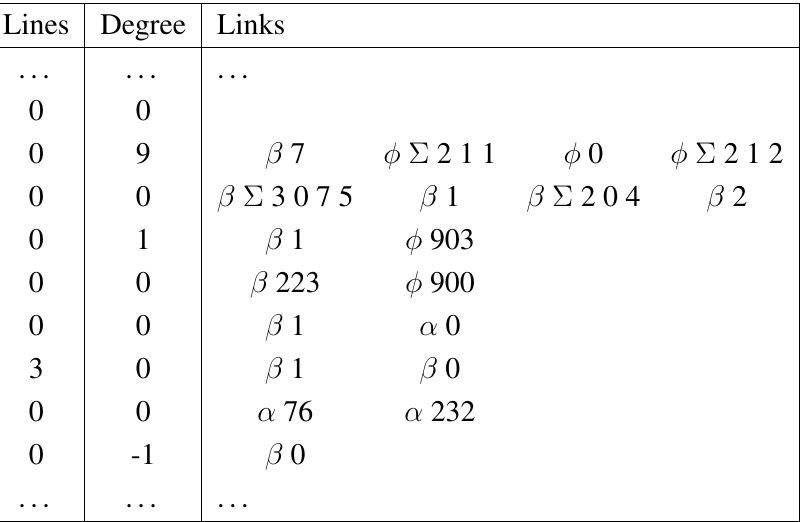
Table 5. An example of adjacency list encoding exploiting redundancies.